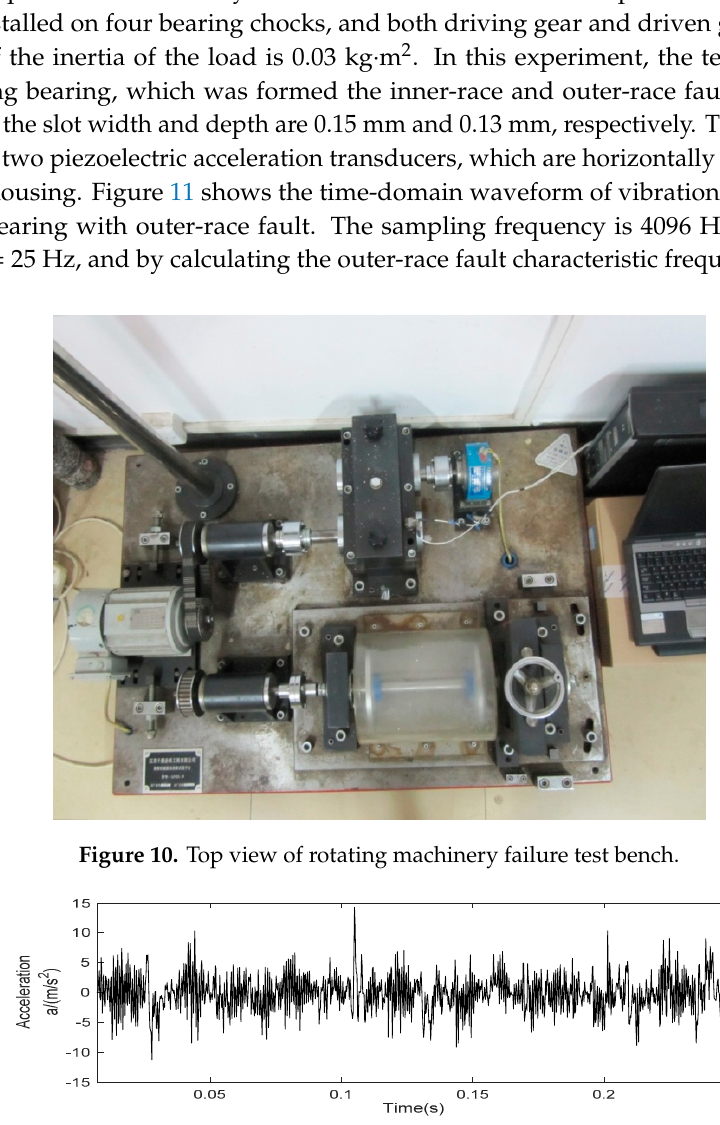
Figure 11. Vibration acceleration signal of the rolling bearing with outer-race fault.